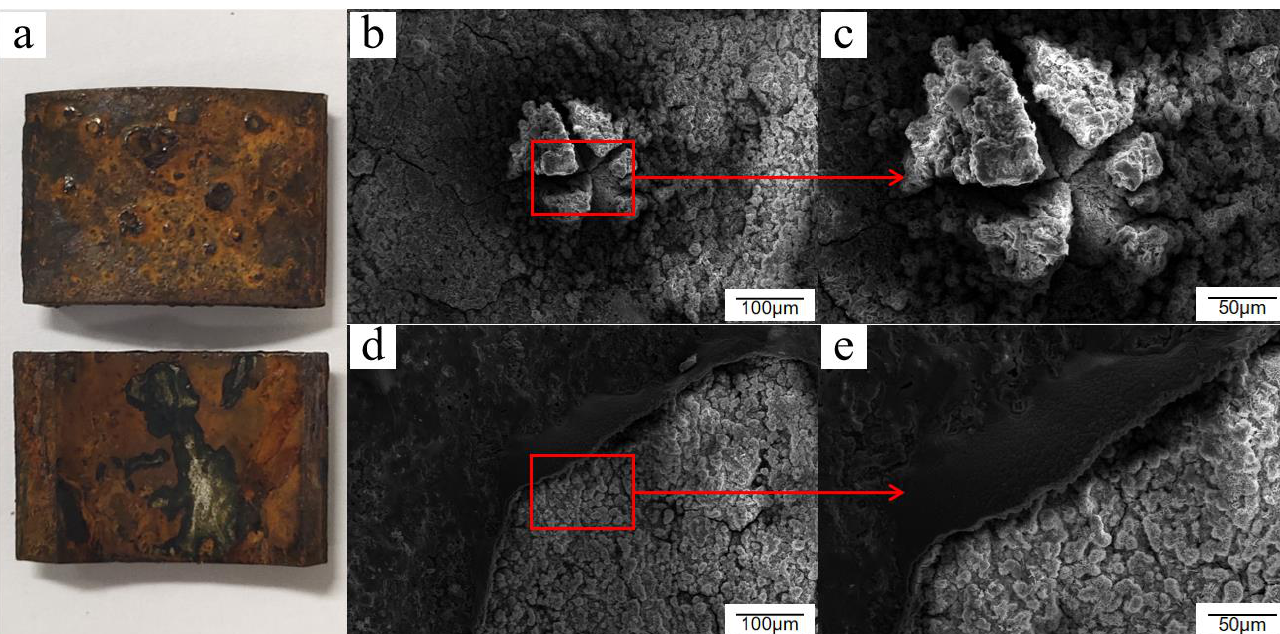
Figure 6. Macroscopic and microscopic morphology of Q235 low-carbon steel after 8 days of exposure in the cyclic salt spray accelerated corrosion test: ( a ) macroscopic appearance, ( b ) ruptured bulge, ( c ) enlarged drawing, ( d ) cracked edge, and ( e ) enlarged drawing.